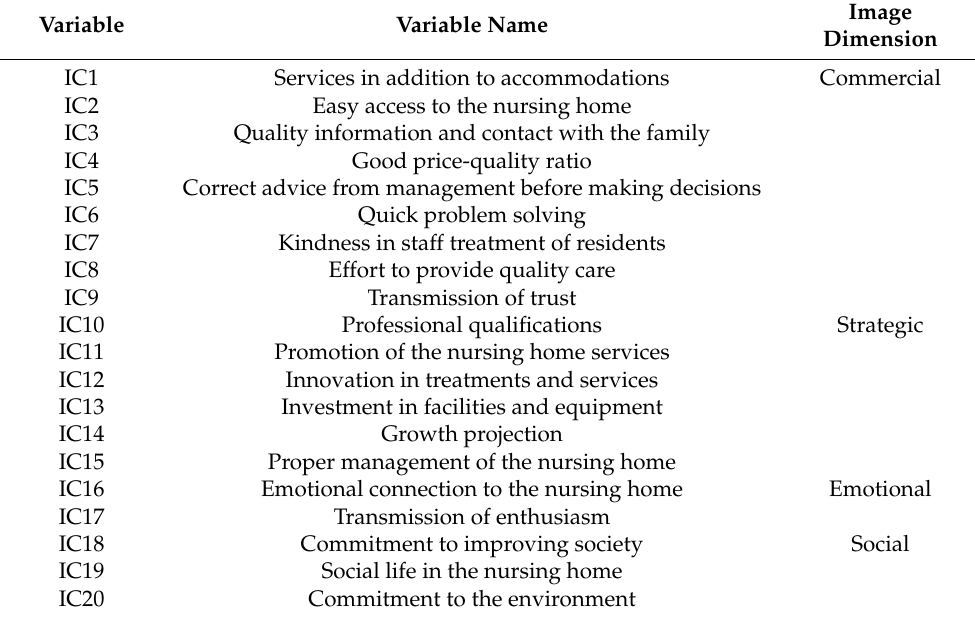
Table 1. Variables of nursing homes’ corporate